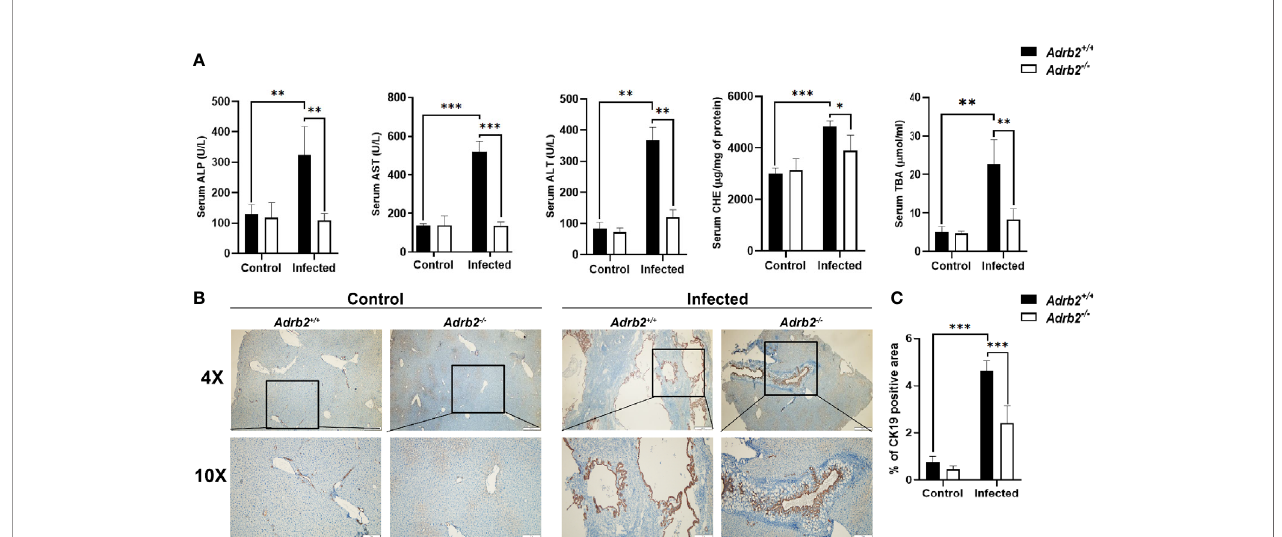
FIGURE 2 | b 2-AR de fi ciency alleviates liver function and cholangiocytes proliferation in mice infected with Clonorchis sinensis . The experimental setup of the in vivo model used n = 4 mice in the control group and n=6 mice in the infected group. The mice were divided into control Adrb2 +/ + , Adrb2 − / − and infected Adrb2 +/ + , Adrb2 − / − mice. (A) Serum analysis of AST, ALT, ALP, TBA, and CHE showed that the liver function signi fi cantly increases in infected Adrb2 +/ + , while in de fi cient mice after C. sinensis infection, the liver function signi fi cantly decreases almost to the level of normal mice. (B, C) The expression of BECs proliferation marker CK19 increases in infected mice compared to that observed in control mice. However, the increase in CK19 in infected Adrb2 +/ + mice signi fi cantly increases compared to infected Adrb2 − / − mice. Compared with indicated groups, * P < 0.05, ** P < 0.01, *** P <